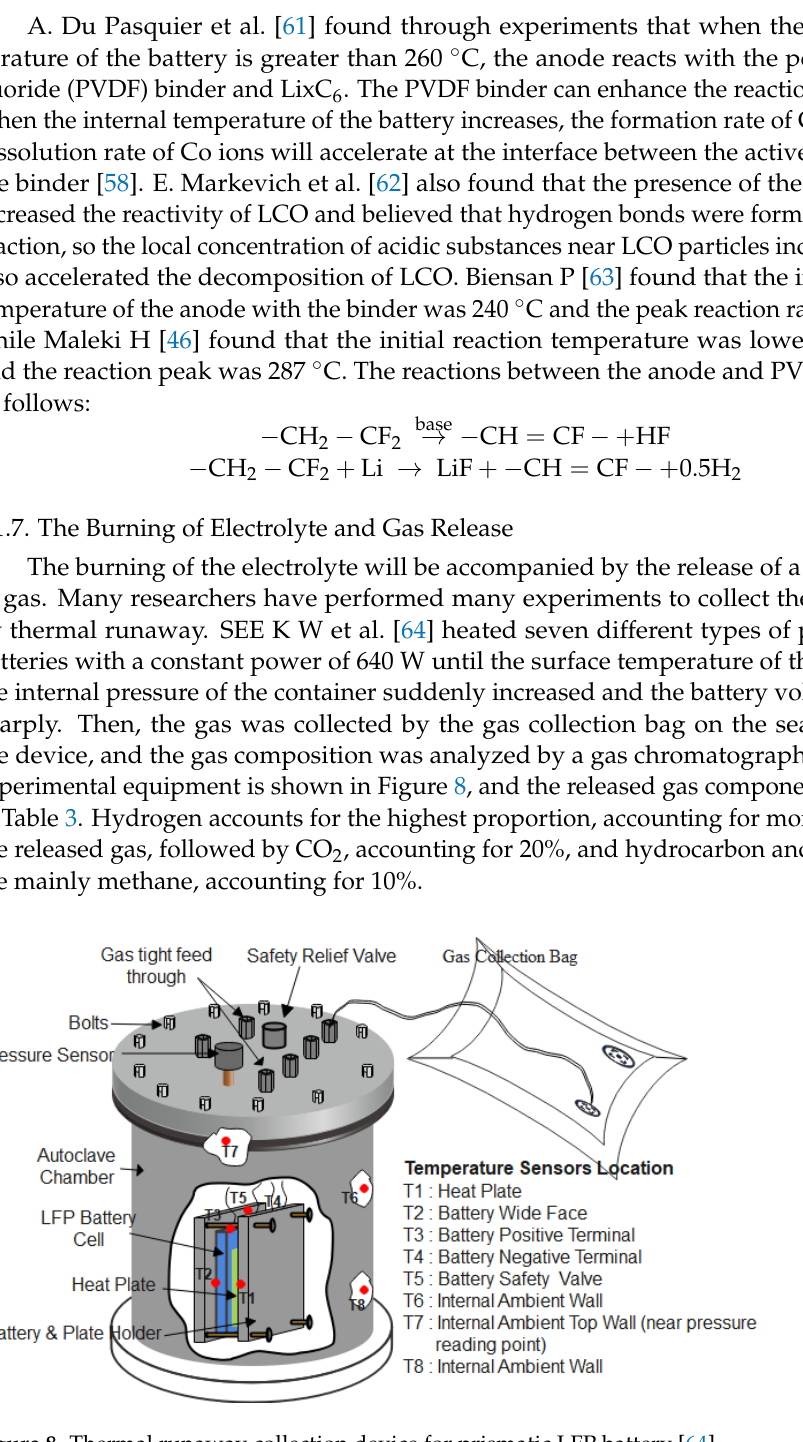
Figure 8. Thermal runaway collection device for prismatic LFP battery [64]. Table 3. Composition of thermal runaway release gas [64].